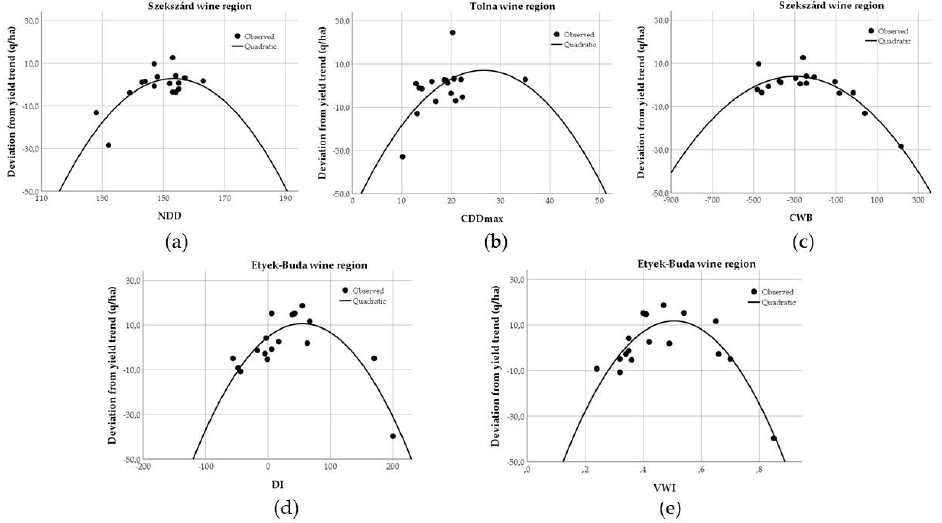
Figure 9. Development of the best regression fits between the studied drought indicators (NDD, CDD max , CWB, DI, VWI) and wine grape yield fluctuations (q/ha) in the Hungarian wine regions for the period 2005 – 2021. ( a ) shows the best fit of NDD; ( b ) shows the best fit of CDD max ; ( c ) shows the best fit of CWB; ( d ) shows the best fit of DI, and ( e ) shows the best fit of VWI.